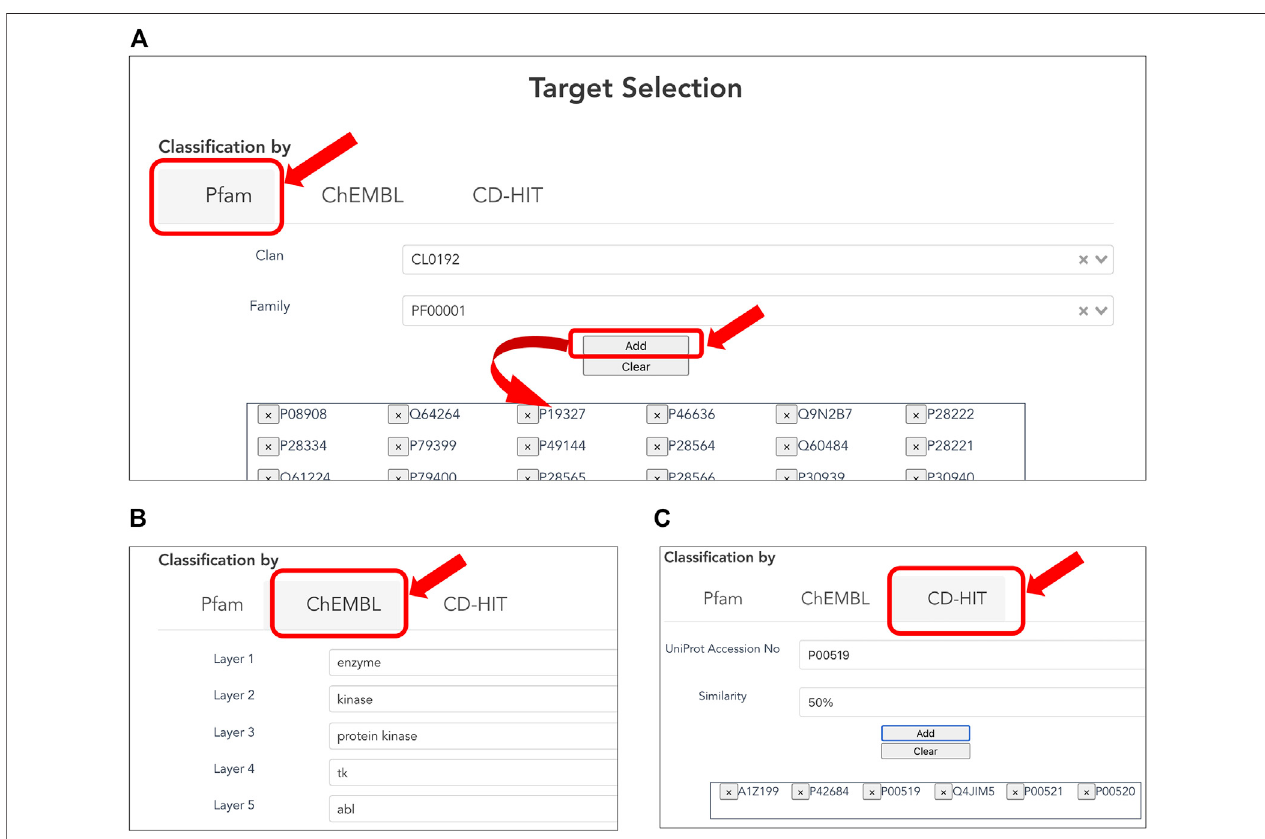
FIGURE2| Selectingtargetproteins. (A) SelectionofproteinfamiliesaccordingtoPfamclans.AlistofproteinfamiliesisdisplayedbytheselectedPfamclan.Users can select one of the Pfam IDs and press the “ ADD ” button to provide the corresponding protein accessions to the form at the bottom. (B) Selection of target proteins accordingtoChEMBLtargetclassi fi cation. (C) Selectionoftargetproteinsbysequencesimilaritybasedonpre-computedCD-HITclusteringresults.Theusercanselect the sequence similarity threshold for clustering from 90, 50, and 40% to provide the corresponding protein accessions.